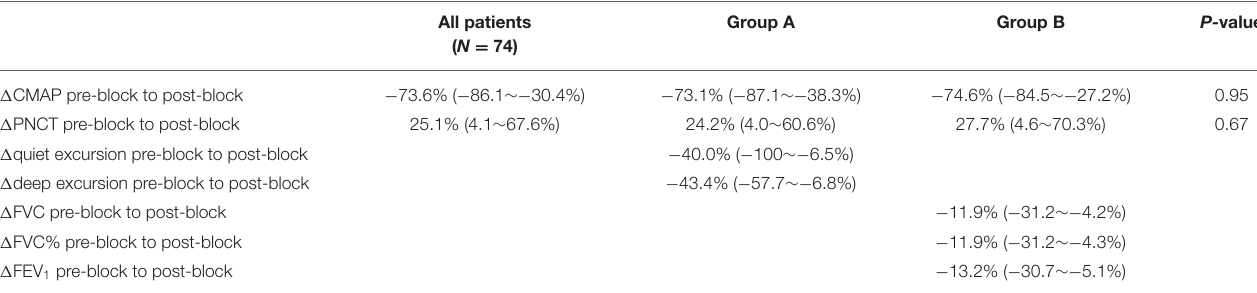
TABLE 2 | Diaphragm compound muscle action potential, diaphragm excursion during SCBPB, and respiratory function